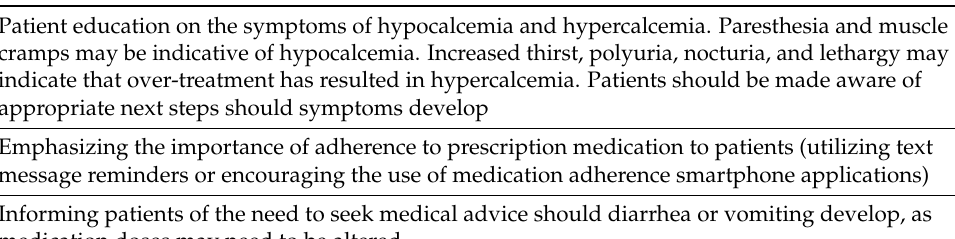
Table 1. A summary of the key priorities for managing hypoparathyroidism during the coronavirus disease 2019 (COVID-19) pandemic